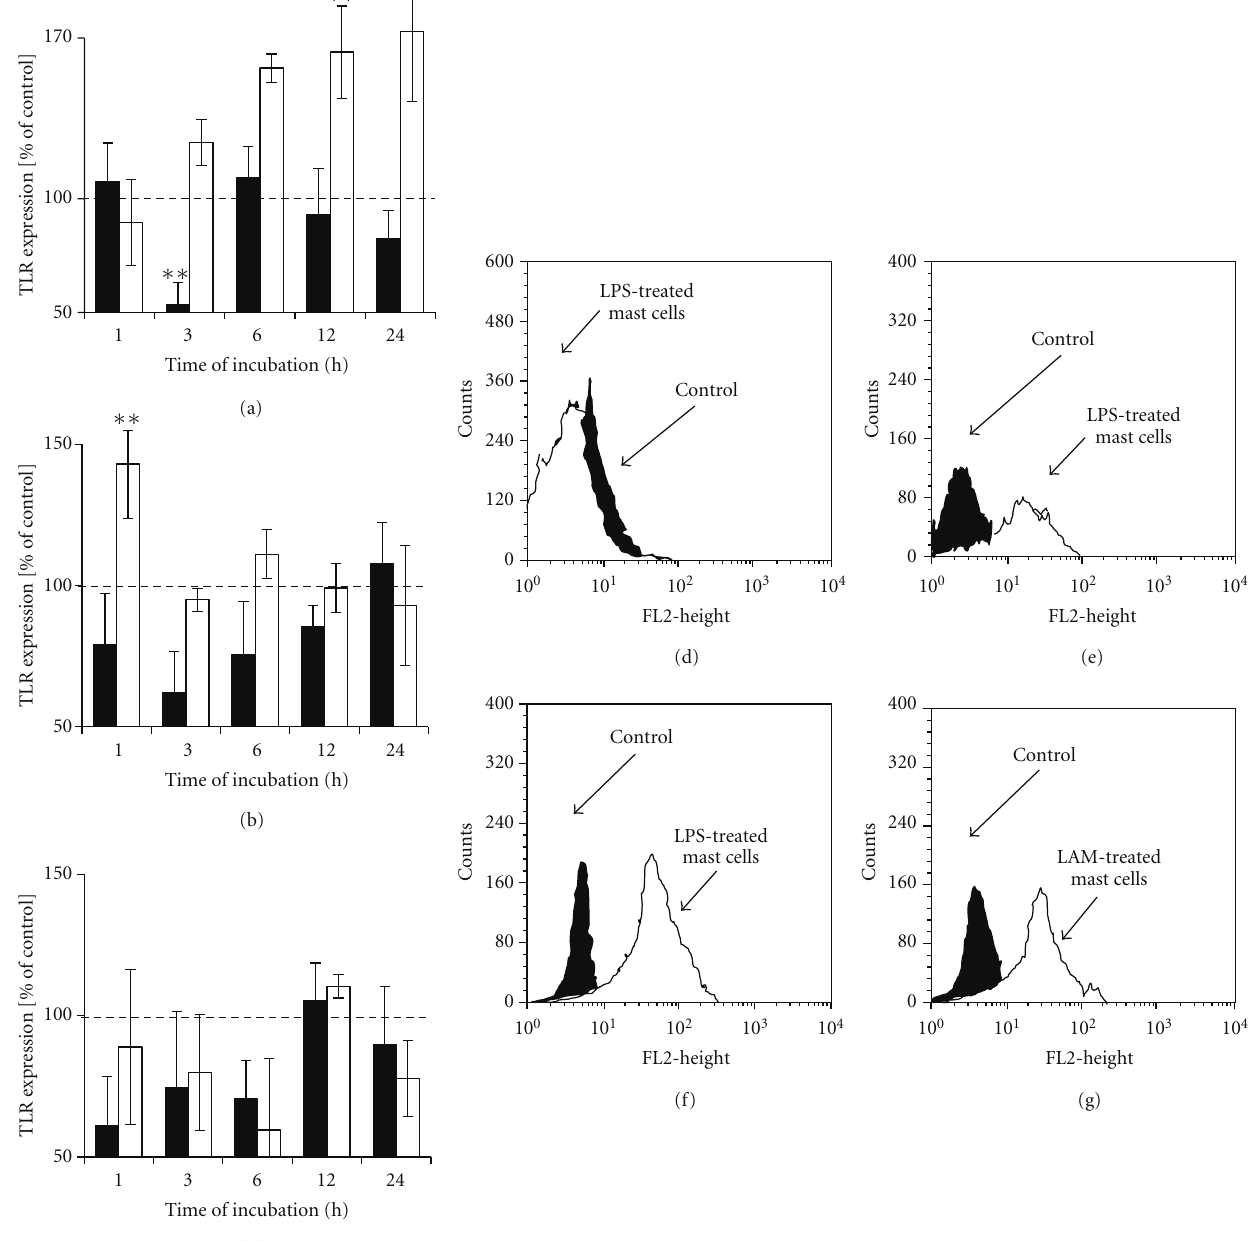
Figure 5: The e ff ect of (a) LPS, (b) LAM, and (c) PGN on TLR4 expression on rat mast cells. Mast cells were incubated with bacterial components or cDMEM (control TLR4 expression on unstimulated cells referred to as 100%) for 1, 3,6,12, or 24 hours. LPS concentrations − 1ng/mL (dark bars) and 10 2 ng/mL (bright bars) and LAM and PGN concentrations − 1 μ g/mL (dark bars) and 10 2 μ g/mL (bright bars). Results are presented as a percentage of control TLR4 expression. Each point represents the mean ± SEM of 6 independent experiments. ∗∗ P < . 01. (d) Representative flow cytometry histogram showing TLR4 expression on rat mast cells treated with 1ng/mL LPS for 3h. (e) Representative flow cytometry histogram showing TLR4 expression on rat mast cells treated with 10 2 ng/mL LPS for 12 h. (f) Representative flow cytometry histogram showing TLR4 expression on rat mast cells treated with 10 2 ng/mL LPS for 24h. (g) Representative flow cytometry histogram showing TLR4 expression on rat mast cells treated with 10 2 μ g/mL LAM for 1h. Filled histograms: untreated mast cells (control) and open histograms: LPS- or LAM-treated mast